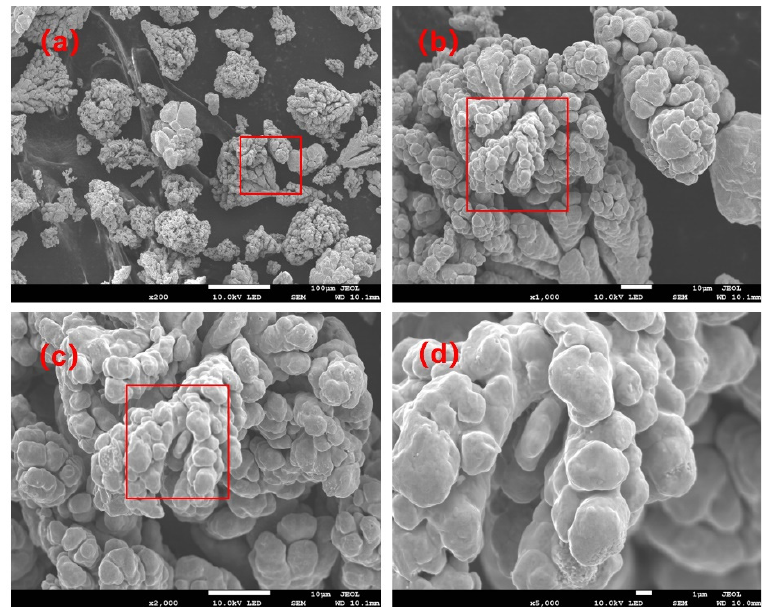
Figure 8. SEM micrographs of reduced copper powder (reduction temperature 350 °C, time 135 min):